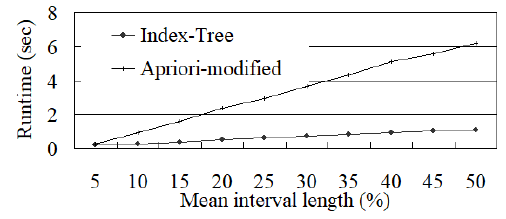
Fig. 13 Runtime vs. mean interval length ( d = 10k, n = 100, s = 5%).